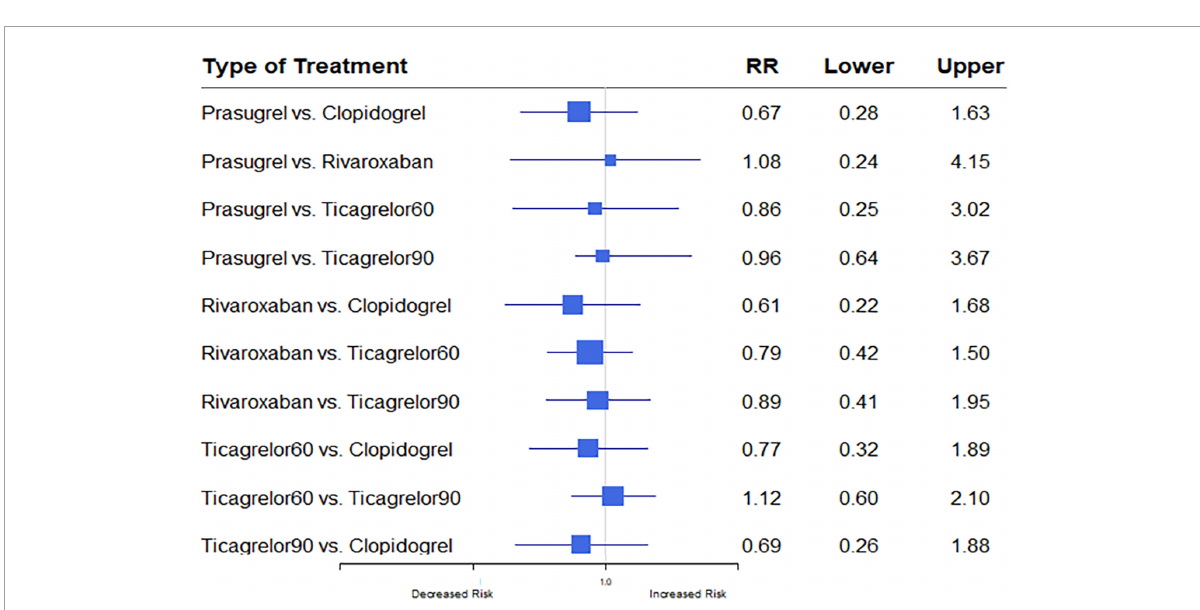
FIGURE8 A network meta-analysis of the association between anti-thrombotic therapy and intracerebral hemorrhage in patients with chronic coronary syndrome. The sizes of the squares are proportional to the weights of each study. The horizontal lines indicate the 95% confidence interval (CI) of each treatment. Net-work Meta-analysis of the Association Between anti-thrombotic therapy and ICH. The size of squares is proportional to the weight of each study. Horizontal lines indicate the 95% CI of each treatment; diamond, the pooled estimate with 95% CI; and RR, relative risk.